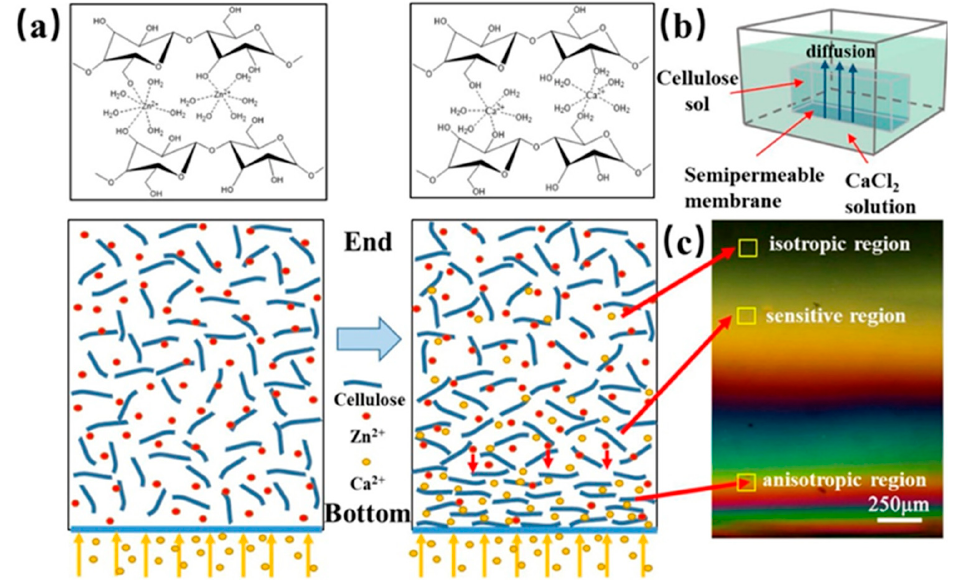
Figure 11. ( a ) Schematic showing the mechanism of preparing gradient hydrogel via the dialysis of cellulose sol in Ca 2+ solution. ( b ) Schematic illustration of Ca 2+ diffusion forming gradient hydrogel. ( c ) Polarized images of different diffusion regions of Ca 2+ in the gel [29].